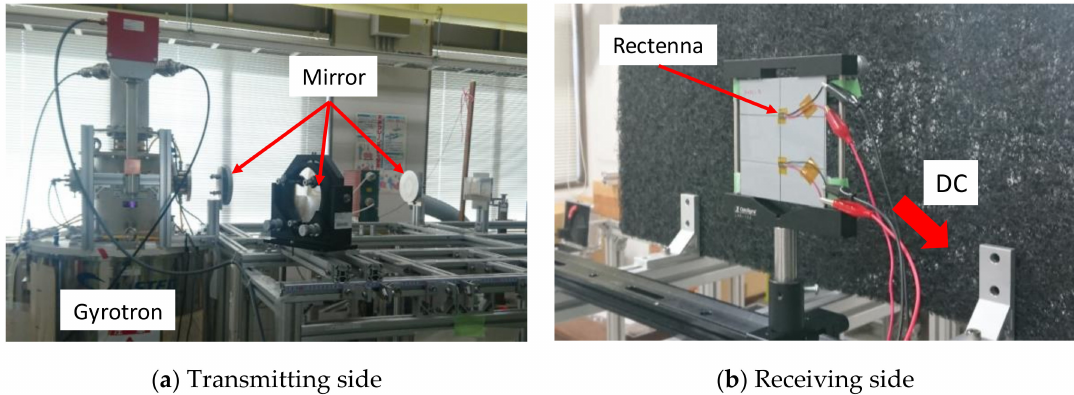
Figure 21. Experimental system of wireless power transmission using a 303 GHz gyrotron: ( a ) transmitting side and ( b ) receiving